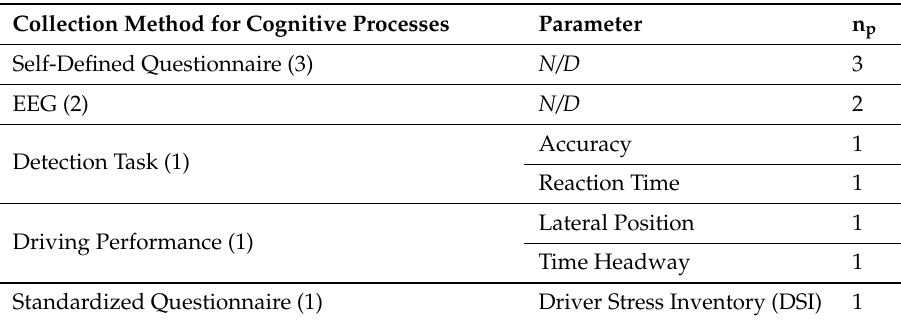
Table 16. Cognitive Processes collection methods and